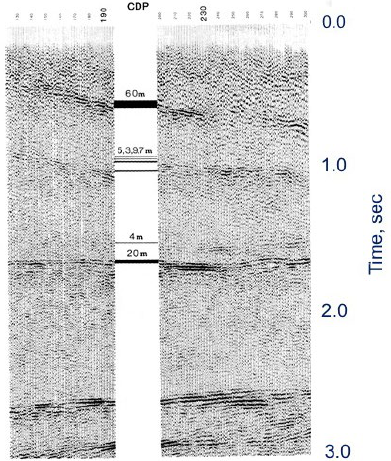
Figure 4. Detail of the Siljan Ring reflections in Figure 3 correlated with the borehole observations of diabase intrusions (solid black lines, with indicated thicknesses [55]). The sills date from 850 to 1700 my. This clear identification of strong reflectivity with mafic sills [55,56] has served as a reference for the interpretation for similar appearing reflection sequences in other areas.